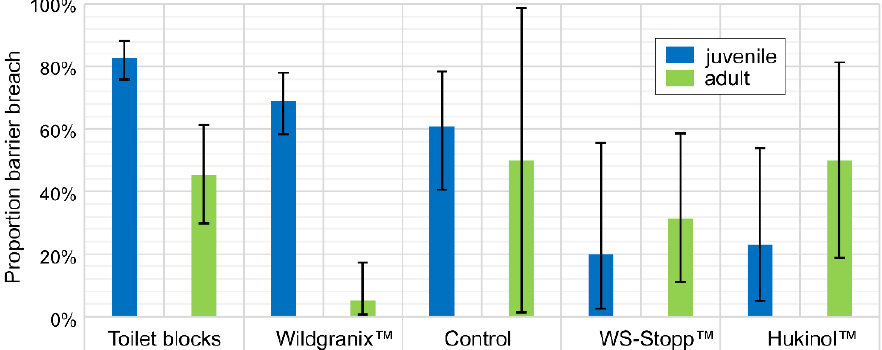
Figure 4. Proportion of barrier breaches with chemical deterrence and 95% confidence intervals.